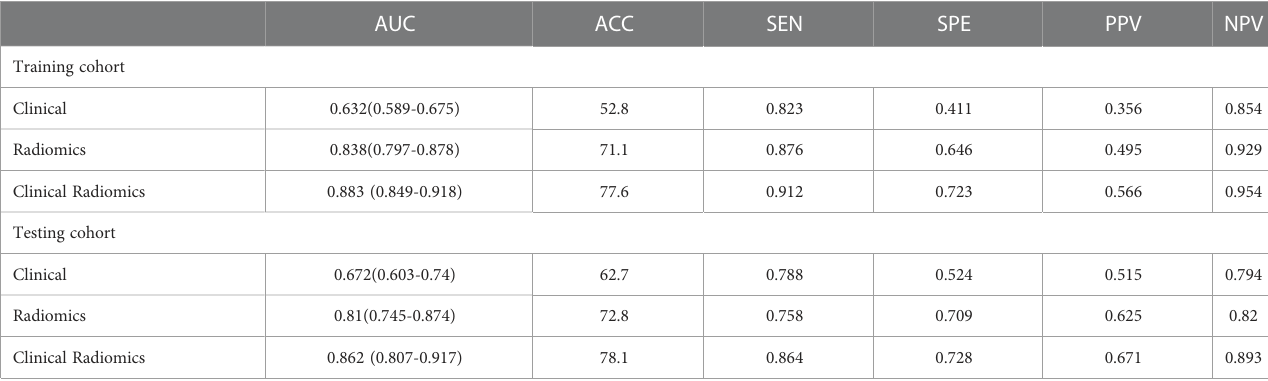
TABLE 3 Performance of the clinical model, radiomics model, and clinical radiomics model in the training and testing cohorts. AUC